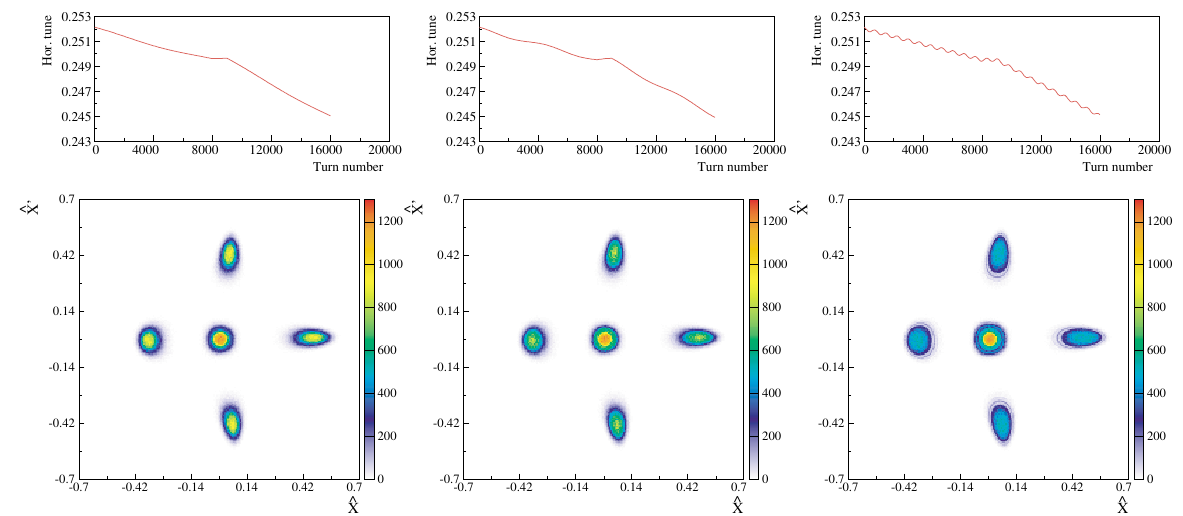
FIG. 8. (Color) Dependence on the tune ripple of beam distribution at the end of the capture process, i.e., after 2 (cid:9) 10 4 turns ( 8 : 1 (cid:9) 10 5 initial conditions) for different values of the ripple frequency. The initial distribution is a Gaussian centered on zero, with standard deviation (cid:21) (cid:1) 0 : 073 . The ripple parameters are a (cid:1) 10 (cid:6) 3 , and b (cid:1) 50 Hz (left panel), 100 Hz (center panel), and 600 Hz (right panel). In this case p (cid:1) 1 .